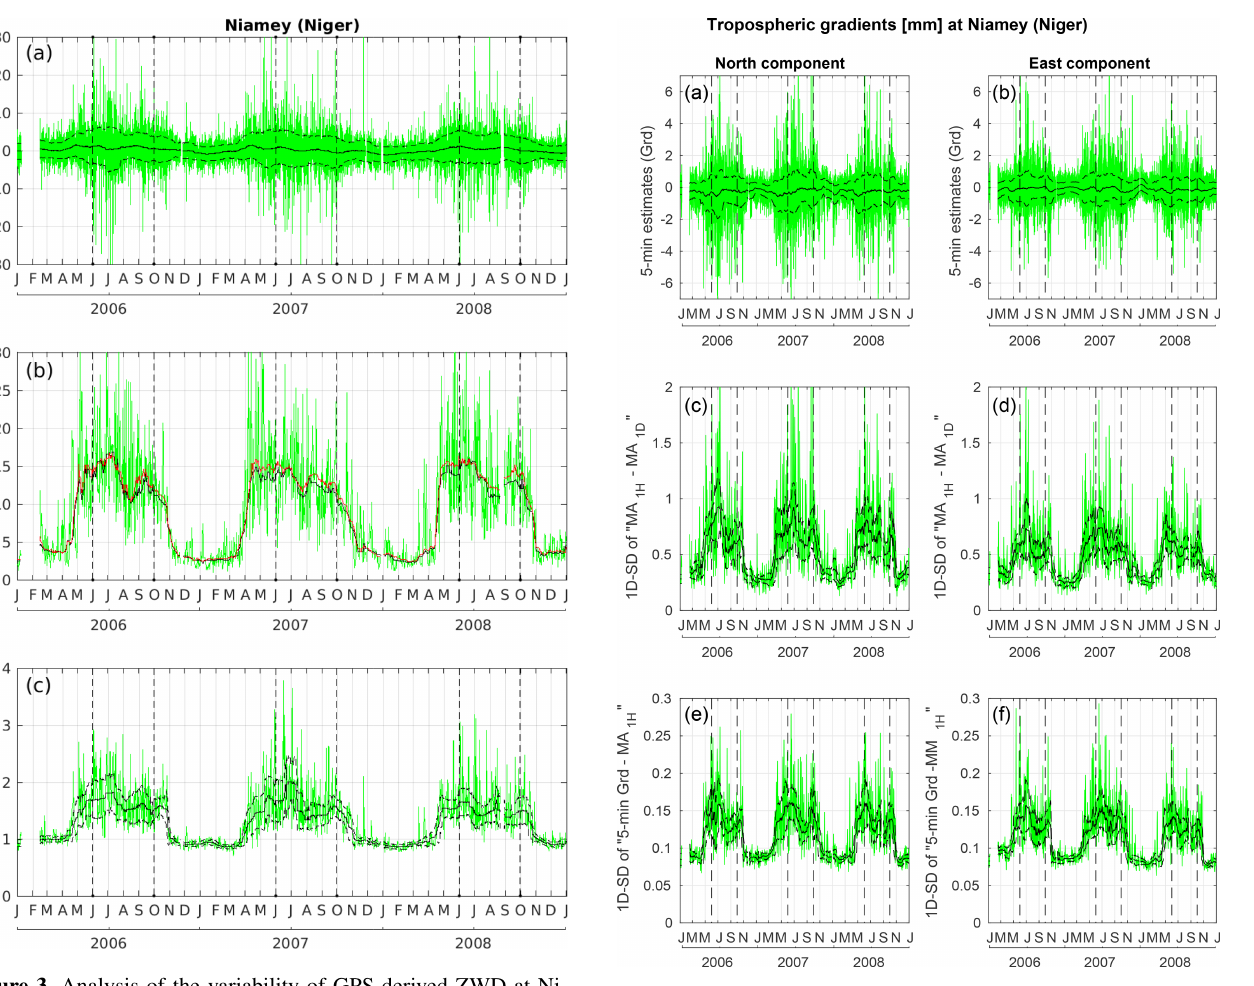
Figure 4. (a) North and (b) east components of the 5min tropo- spheric gradients retrieved with the GIPSY-OASIS software at Ni- amey between 2006 and 2008, with the 30d moving averages shown as solid black lines, and the 30d moving standard deviations around the means shown as dashed black lines. (c, d) Sub-daily variability of north and east gradients (similar to Fig. 3b). (e, f) Sub-hourly variability of north and east gradients (similar to Fig. 3c). In pan- els (c) – (f) , the solid black lines show 30d moving medians, and the dashed black lines show moving median absolute deviations around the medians. The dashed black vertical lines indicate the JJAS pe- riod of each